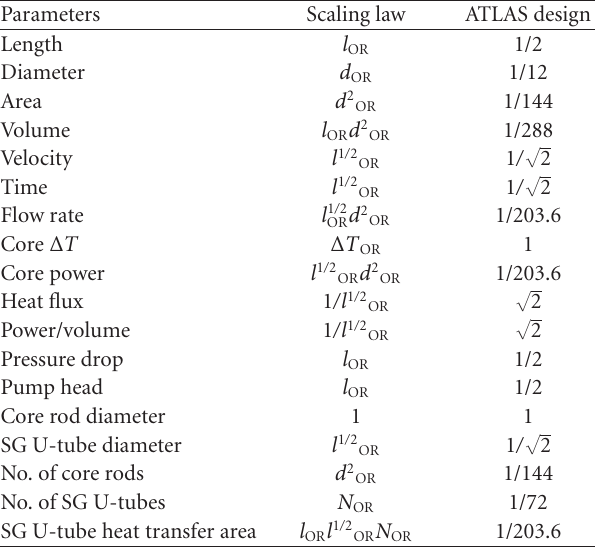
Table 1: Scaling table of the ATLAS